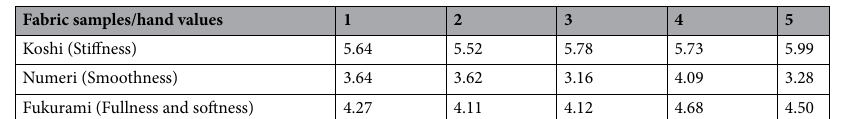
Table 2. Primary Hand Values. *Sample 1—Control, Sample 2—Glutaraldehyde treated, Sample 3—Sericin and glutaraldehyde treated, Sample 4—Plasma treated, Sample 5—Plasma and sericin and glutaraldehyde treated.